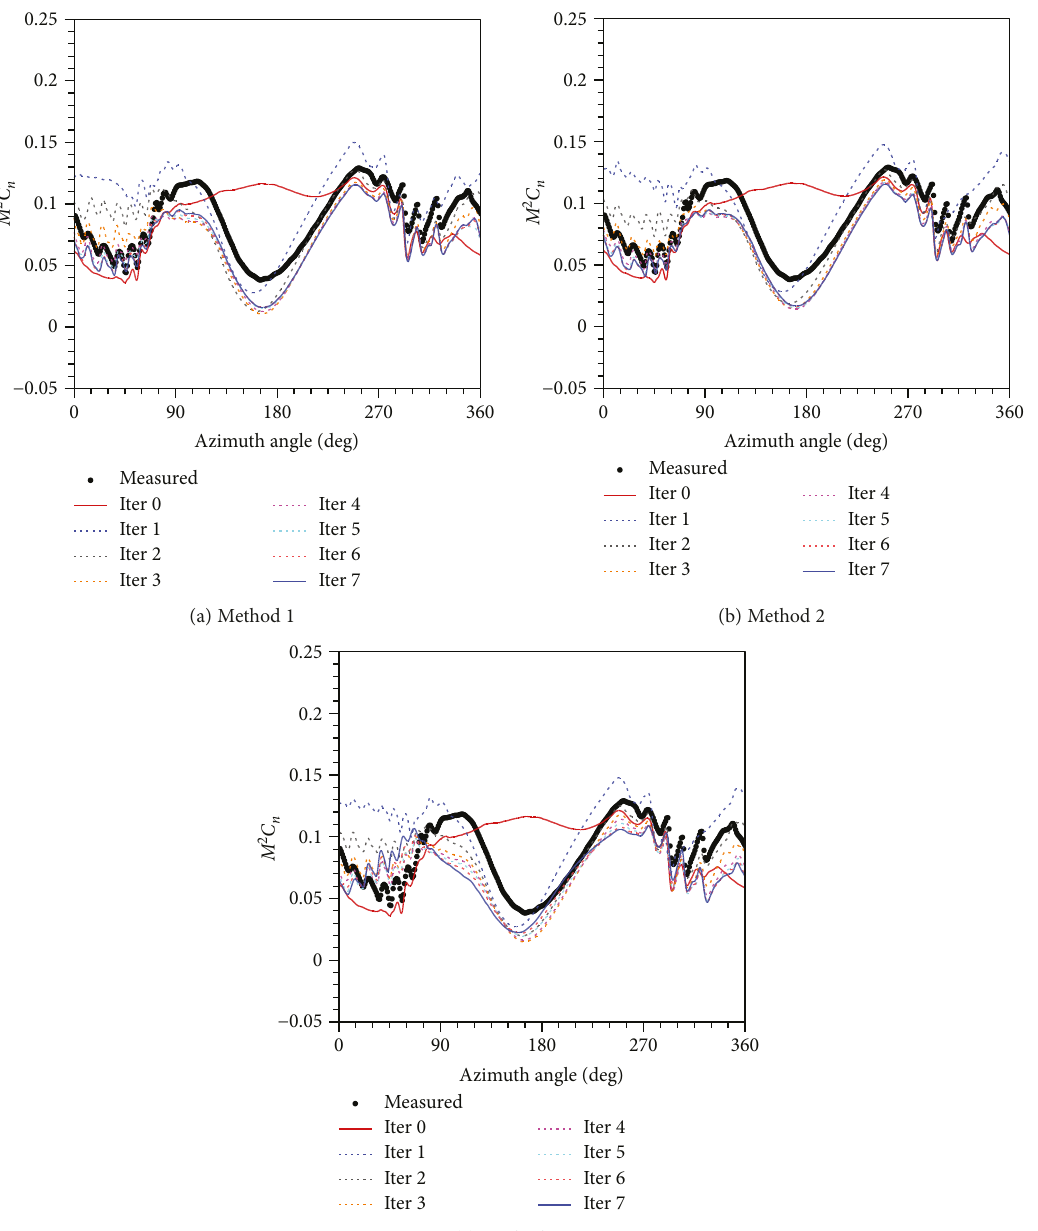
Figure 6: Comparison of convergence on section airloads M 2 C